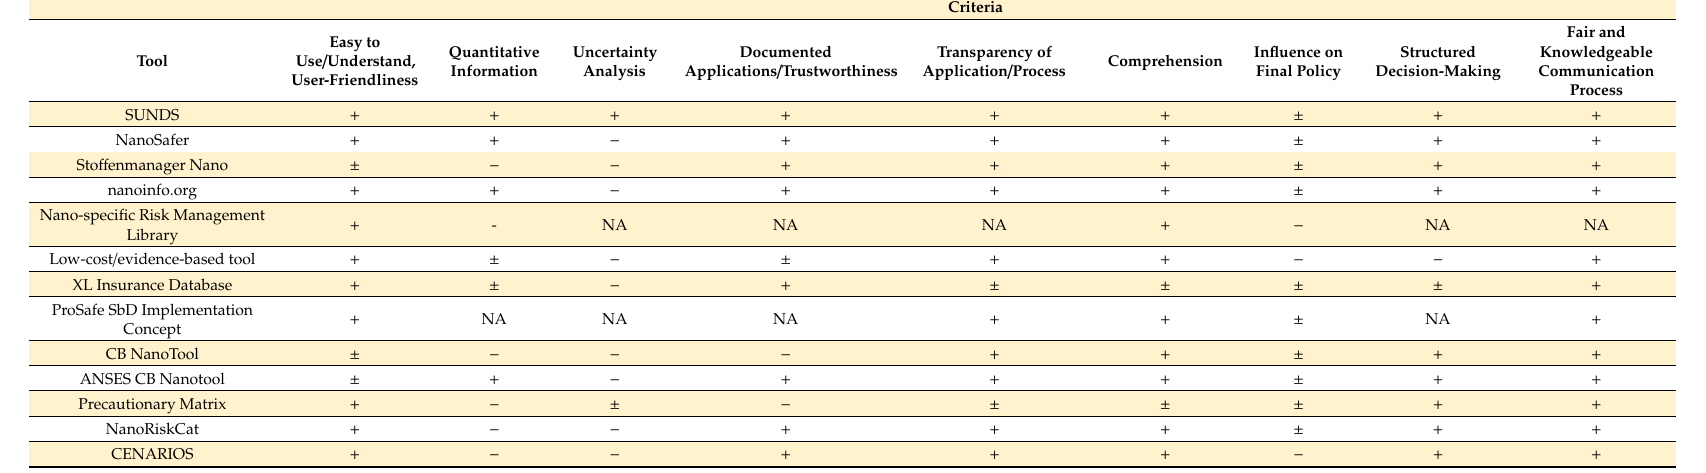
Table 4. Evaluation of the Risk evaluation, Risk management–Decision-making and support and Monitoring tools, according to 9 relevant criteria. + Criterion fulfilled; − Criterion not fulfilled; ± Criterion not fully fulfilled; NA Criterion not applicable /